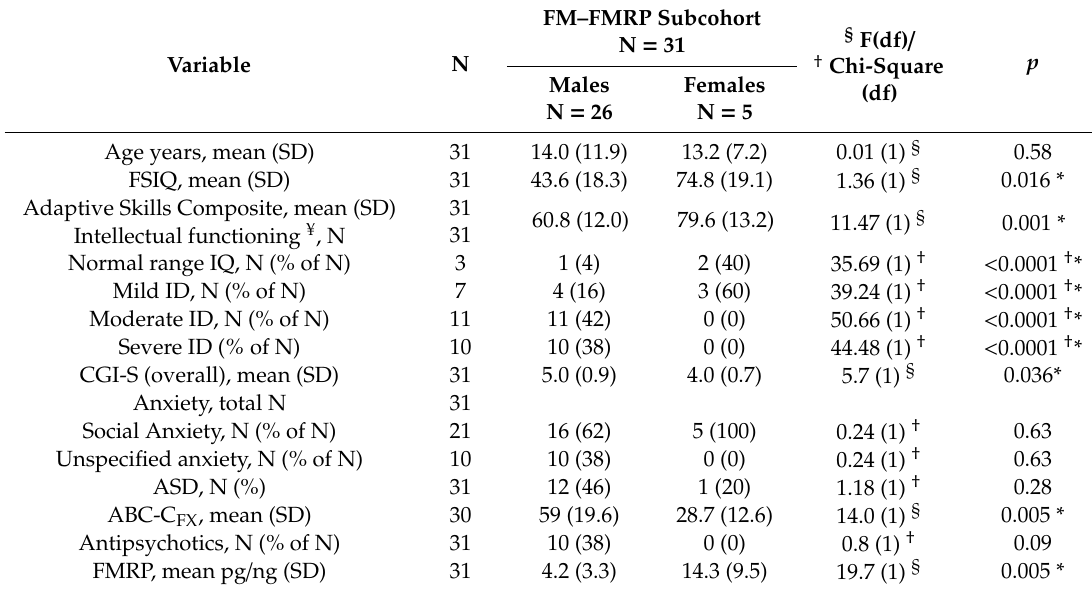
Table 5. Neurobehavioral profiles by gender in the FM–FMRP